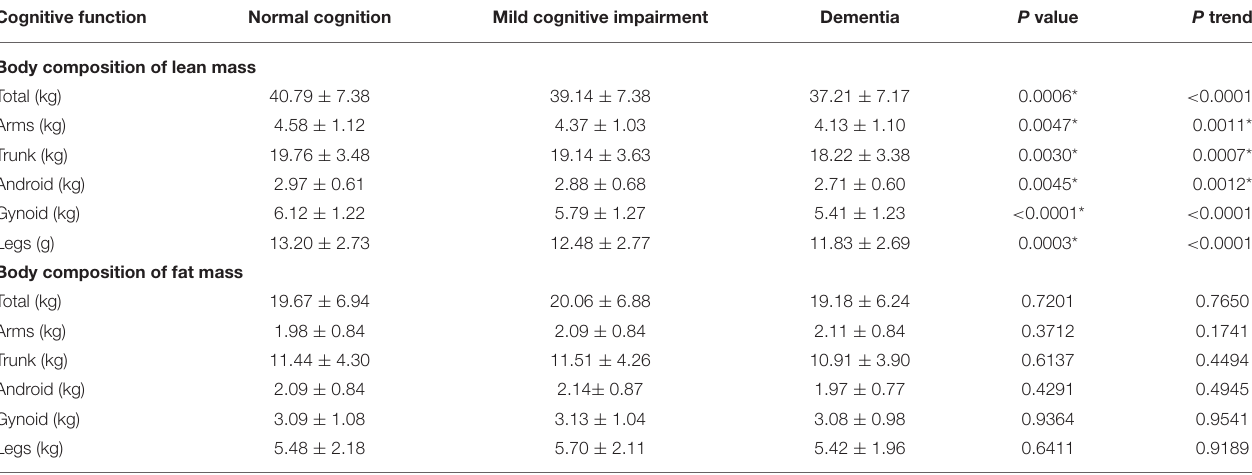
TABLE 3 | Dual-energy X-ray absorptiometry measurements for body composition in the three cognitive groups. Cognitive